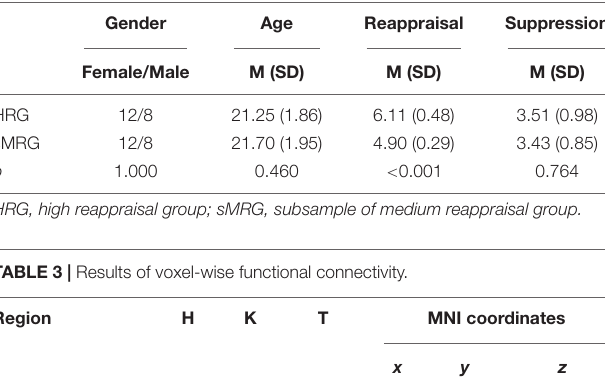
TABLE 2 | Comparison of behavioral assessment between HRG and sMRG.